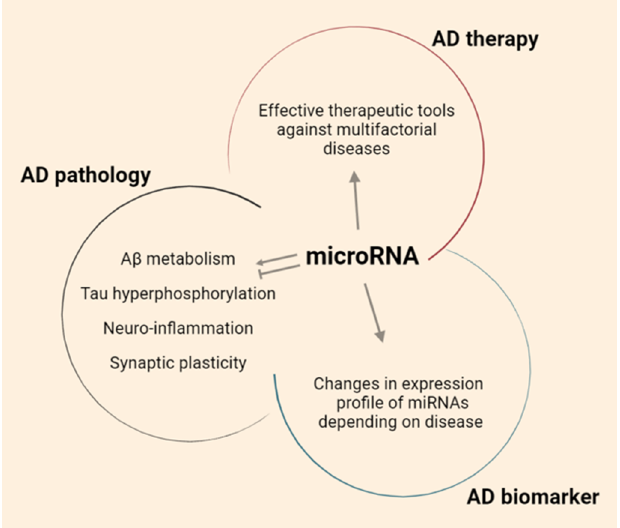
Figure 1. The role of miRNAs in